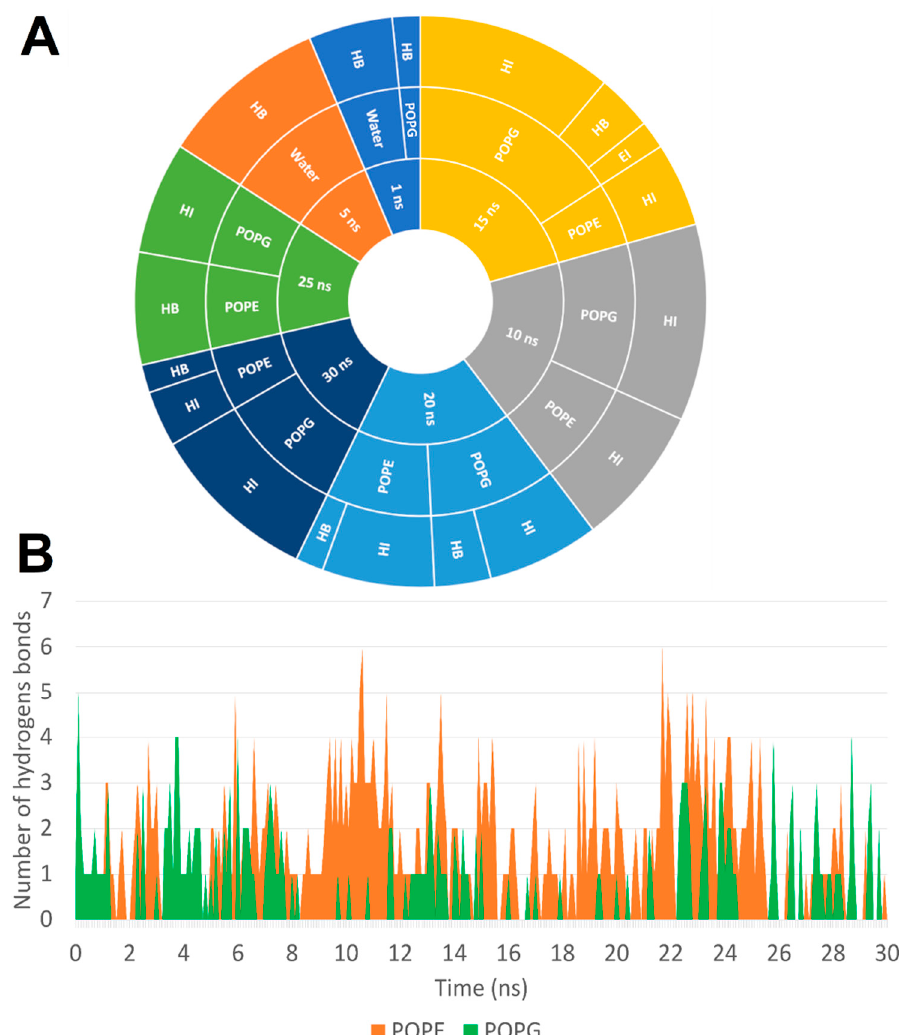
Figure 5. Intermolecular interactions between Bz-Im and the E. coli membrane model ( A ) at 1 ns (blue color), 5 ns (orange color), 10 ns (gray color), 15 ns (yellow color), 20 ns (light blue color), 25 ns (green color), and 30 ns (dark blue color). HB, hydrogen bond; HI, hydrophobic interaction; EI, electrostatic interactions. ( B ) Hydrogen bonds between Bz-Im and the phospholipids of the system. POPE, phosphatidylethanolamine; POPG, phosphatidylglycerol.